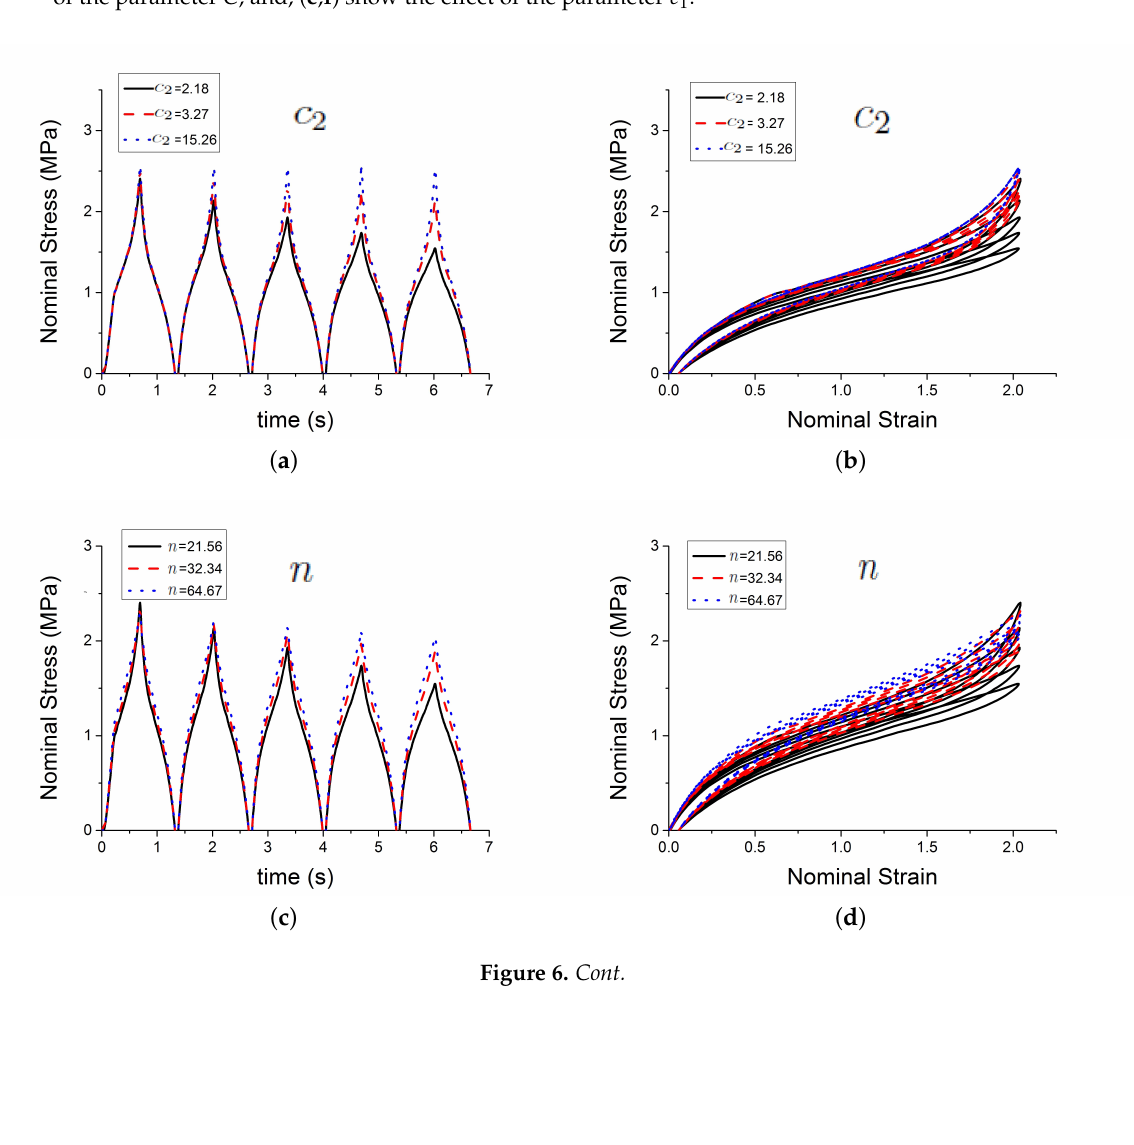
Figure 5. Influence of parameters. ( a , b ) show the effect of the parameter χ ; ( c , d ) show the effect of the parameter C ; and, ( e , f ) show the effect of the parameter c 1 .